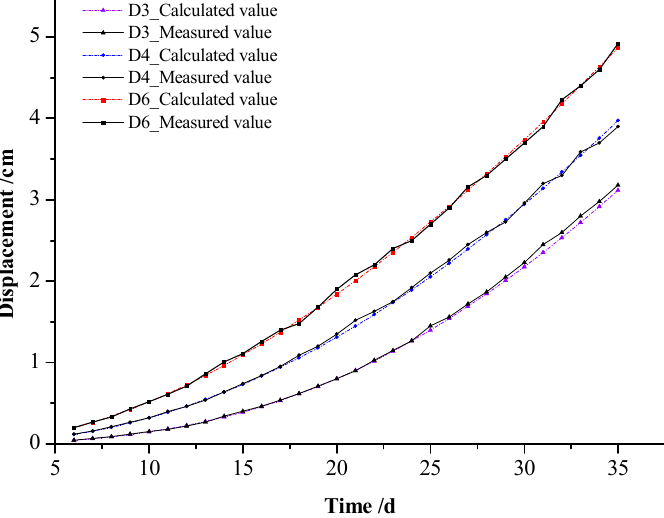
Figure 7. Comparison of measured and calculated values.